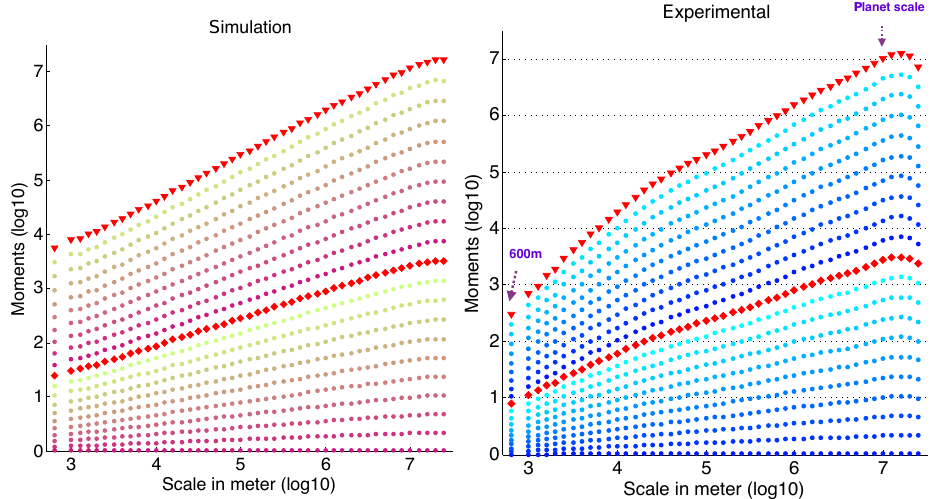
Figure 1. Statistical moments of several orders (from 0.1 to 2) as a function of scale for simulated series (left plot) and for actual MOLA data (right plot). In both plots, red diamonds (or red triangles) stand for moment of order 1 (or order 2). Integer-ordered moments are also computed in order to test the multifractal formalism. They are plotted in shades of red (left plot) and blue (right